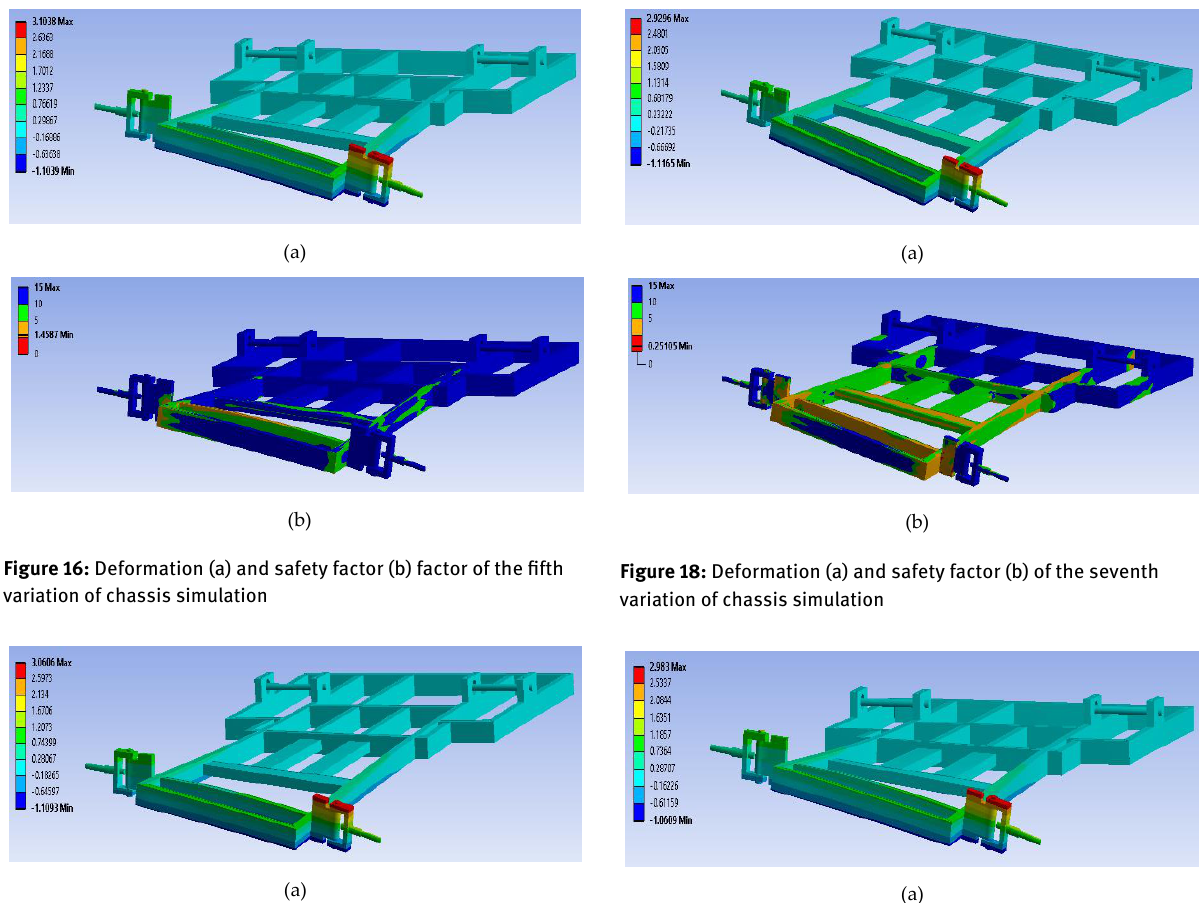
Figure 19: Deformation (a) and safety factor (b) of the eighth varia- tion of chassis simulation